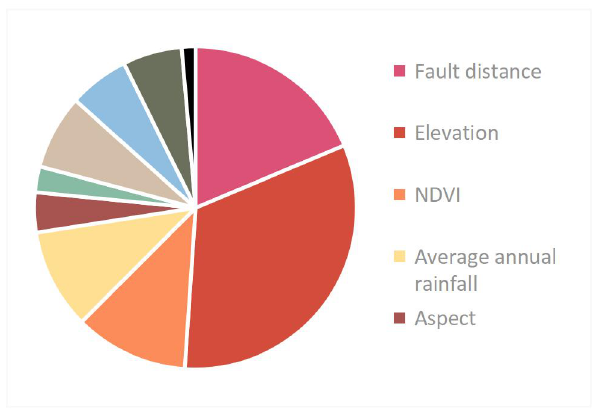
Figure 12 . Average CF value.